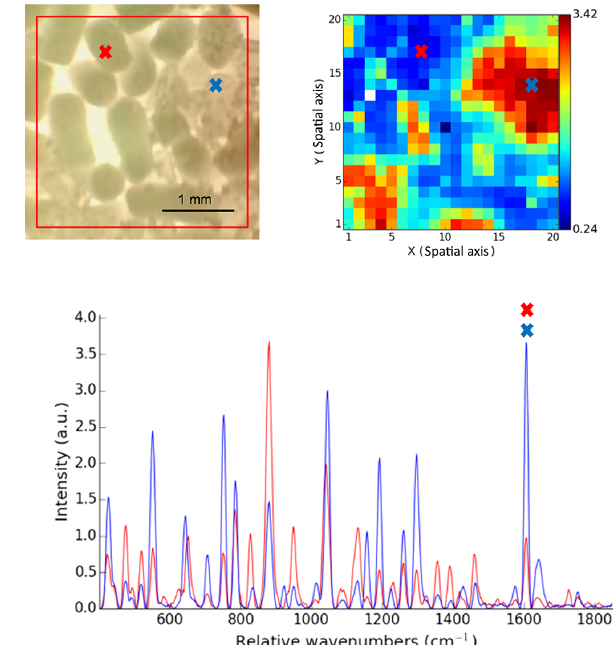
Fig. 7: Granules and powder of the pain reliever Aspirin Effect. Upper left: Camera picture. Upper right: Pseudo color Raman image of the intensity at 1606 cm -1 , which corresponds to the distribution of the agent acetylsalicylic acid. Below: Corresponding SERDS spectra at the positions and (1 s recording time per laser).